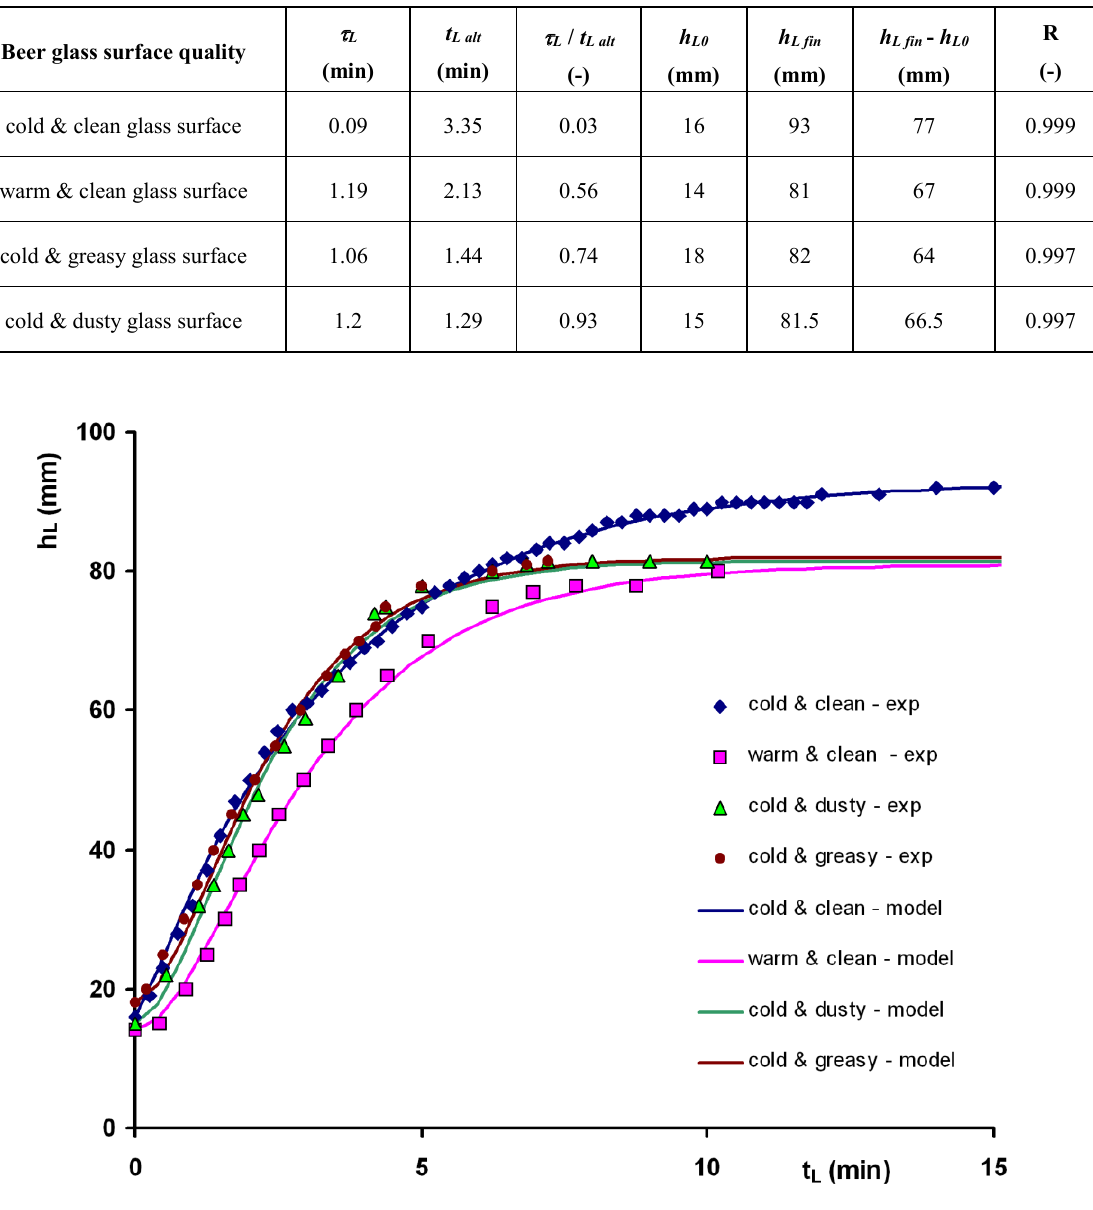
Fig. 6. Liquid formation – effect of beer glass surface